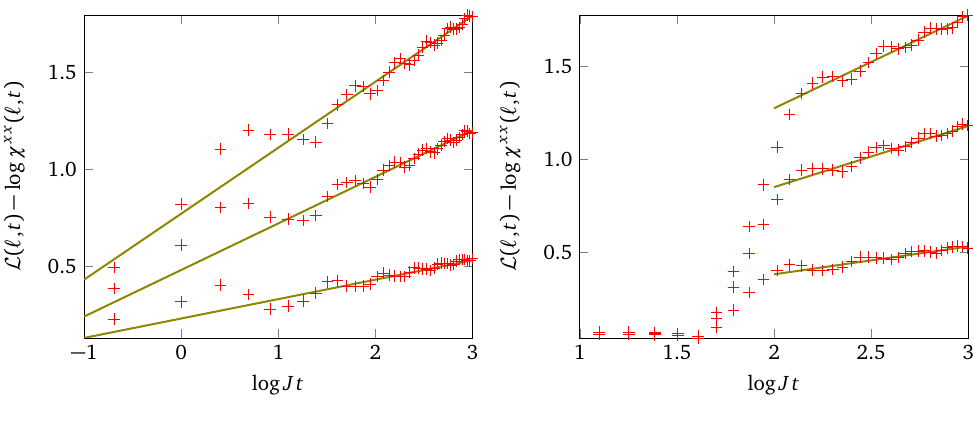
Figure 13: L ( (cid:96) , t ) − log χ xx ( (cid:96) , t ) with χ xx ( (cid:96) , t ) given by (143) as a function of log J t for h = 0.5 and β = 0.5,0.286,0.2 from bottom to top inside each panel, with (cid:96) = 0 (left) and (cid:96) = 5 (right) in red. In green is indicated a linear fit in the time-like region v t > (cid:96) max